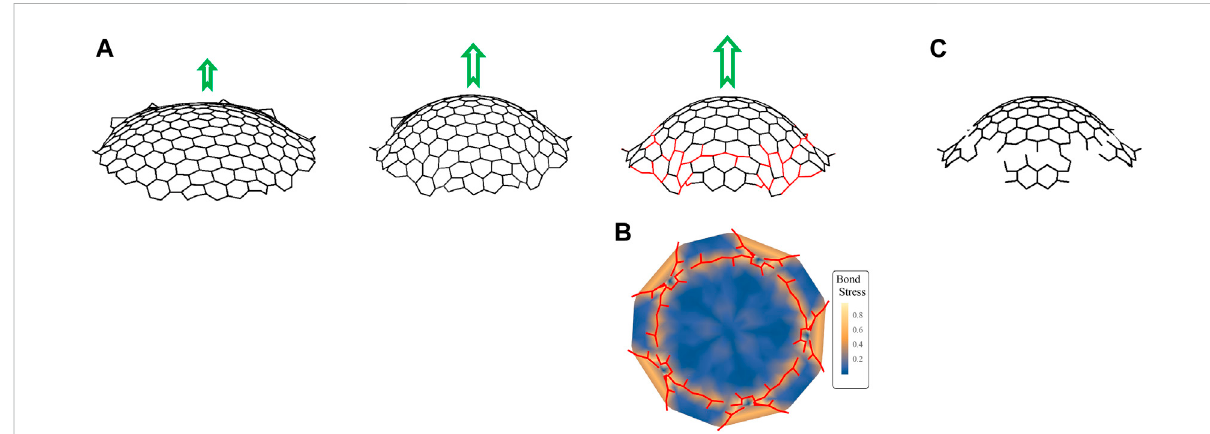
FIGURE 5 Simulations of GCP segments. (A) Snapshots of simulations showing the evolution of a clathrin complex grown from a sheet of hexagons surrounding a central pentagon into a dome with increasing force (represented by green arrows). The parameters used in simulations are k s (cid:2) 500 , (cid:2) 0 . 64 , k b (cid:2) 10 − 8 , k p (cid:2) 100 and θ (cid:2) 2 π /3. Red lines in the fi nal stage of the dome denote the bonds that break due to bond stress exceeding the l 0 0 thresholdof0.3. (B) Thebondstressmap S B ofthe fi nalstageofthedome,asgivenby(Eq.A.6),asviewedfromabove. (C) Thesameclathrincoat with the broken bonds removed, along with small, detached